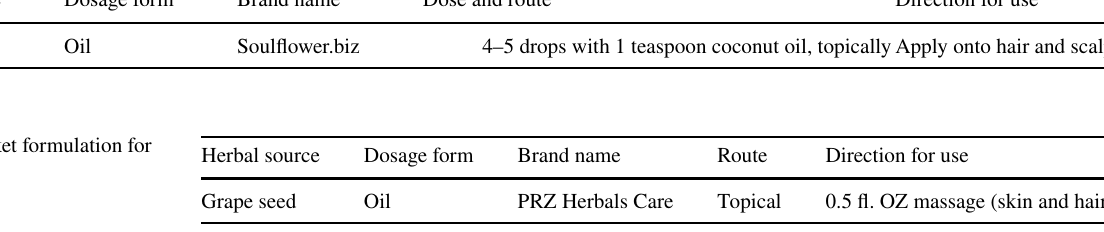
Table 8 Market formulation for rosemary Herbal source